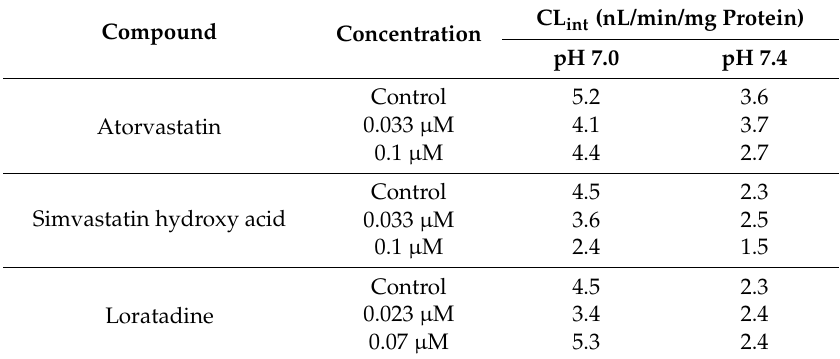
Table 1. Kinetic parameters of L -lactic acid influx following a six-day pretreatment with atorvastatin,